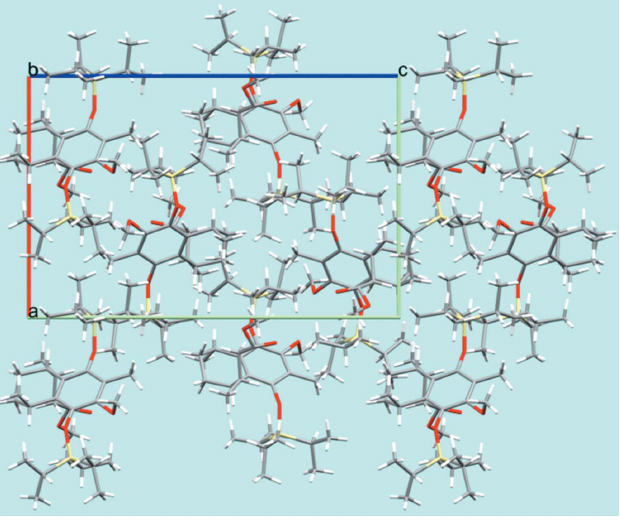
Figure 4 Molecular packing of ( 2 ) in the crystal structure, shown in a view along [010]. Only the major occupancy component of the positionally disordered groups is shown; C—H (cid:2)(cid:2)(cid:2) O hydrogen bonds are omitted for clarity.